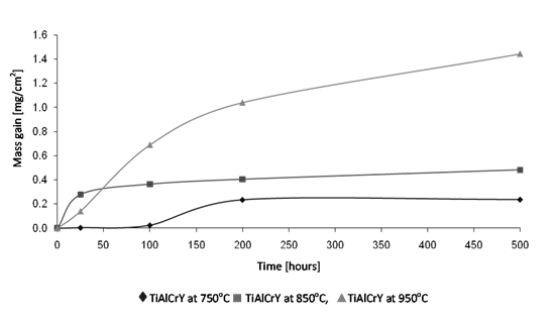
Figure 2. Mass change data obtained for exposed samples to static air at 750 ◦ C, 850 ◦ C, and 950 ◦ C for 500 hours